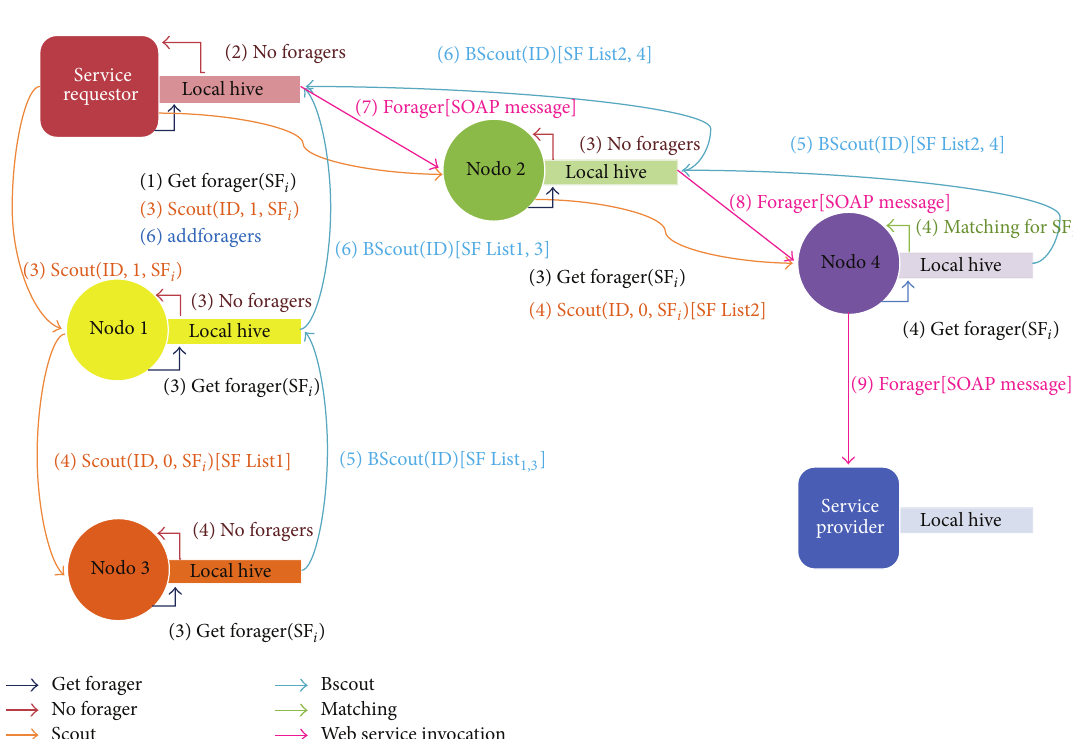
Figure 6: BeeAdHocService Discovery working